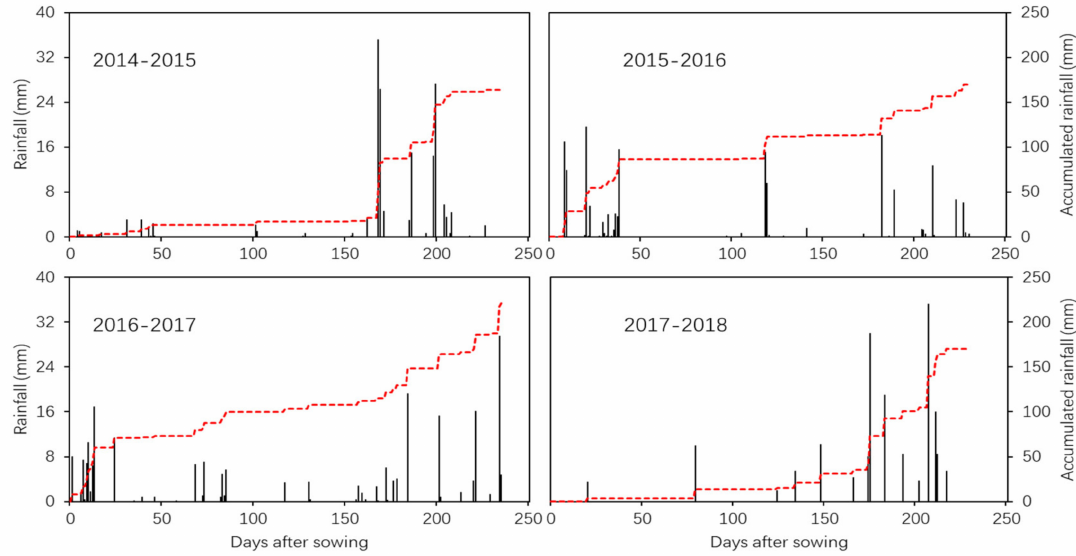
Figure 1. Accumulated rainfall in the winter wheat growing seasons from 2014 to